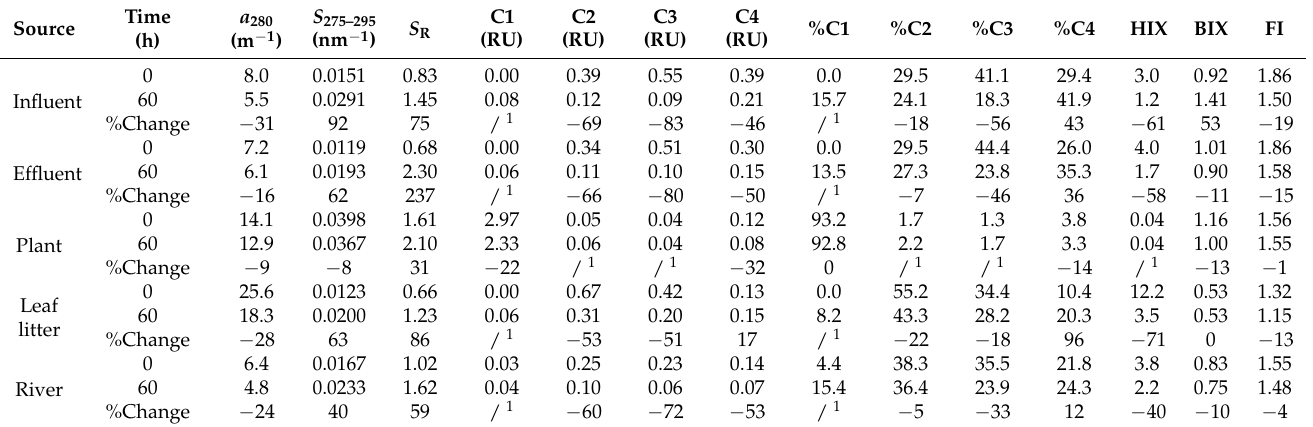
Figure 1. ( a ) The absorbance spectra of CDOM from different sources, ( b ) changes in the absorption coefficient of CDOM ( a 280 ) with the irradiation time, and ( c ) changes in the spectral slope ( S 275–295 ) and slope ratio ( S R ) by the irradiation, with the arrows showing the direction of changes. Table 1. Changes of optical indices by photodegradation.